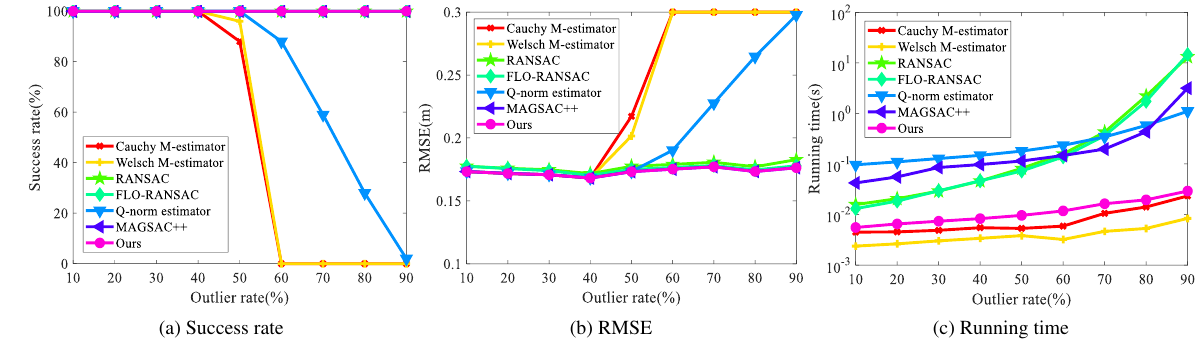
Figure 9. Comparison of point set registration results on the simulated data.